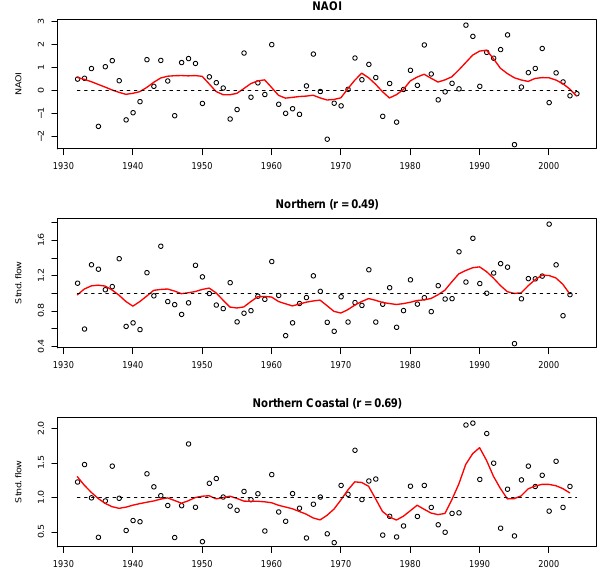
Fig. 9. Time series plots and LOESS smoothing lines for the December–March NAOI and December–March average flow for the two northern regions. Spearman’s rank correlation coefficient be- tween winter flows and NAOI is